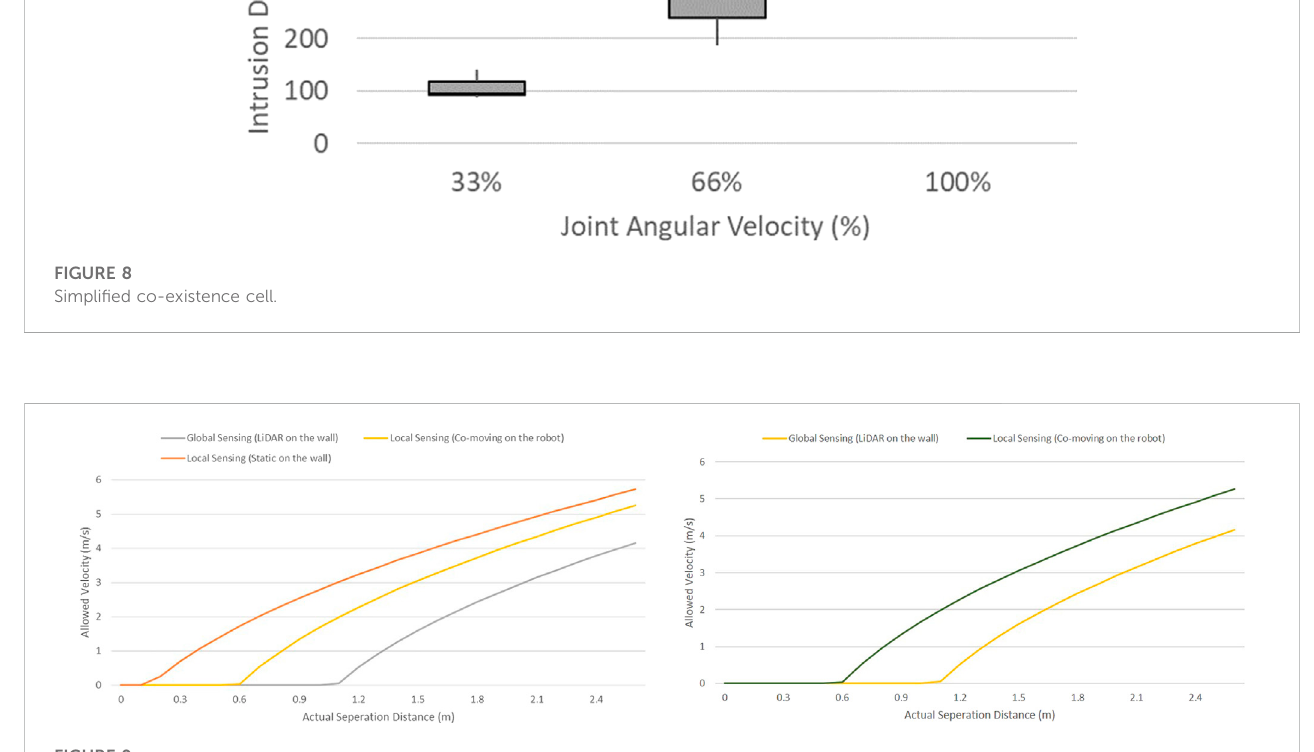
FIGURE 9 Complete trajectory for collision sensing and stop trigger for a single